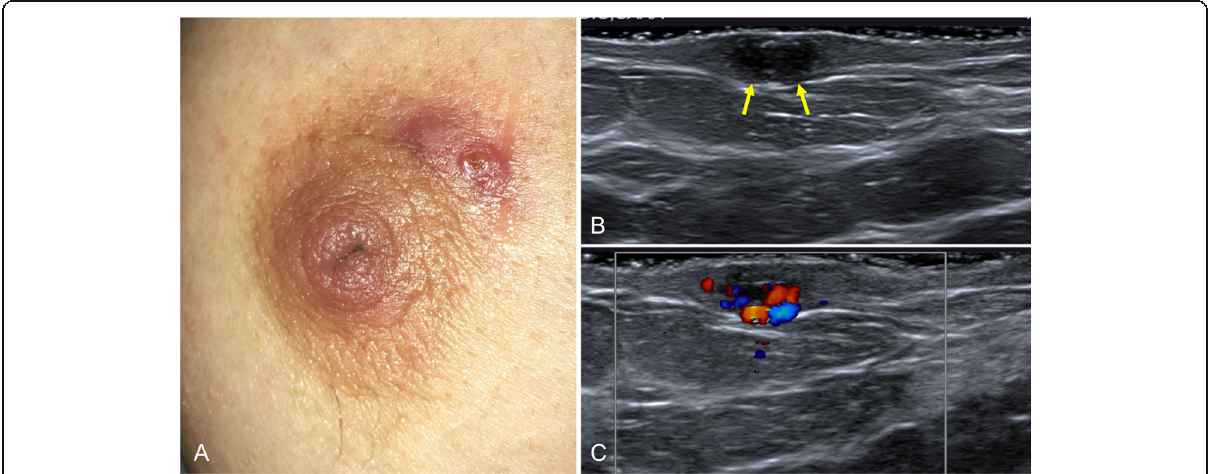
Fig. 23 Zuska ’ s disease. a Photograph of a 47-year-old woman with a history of smoking who had a recurrent painful erythematous palpable subareolar mass with a small secreting ulcerous lesion. b Ultrasound shows skin thickening with a small hypoechogenic collection below the lesion (arrows), with increased peripheral color-Doppler signal ( c )